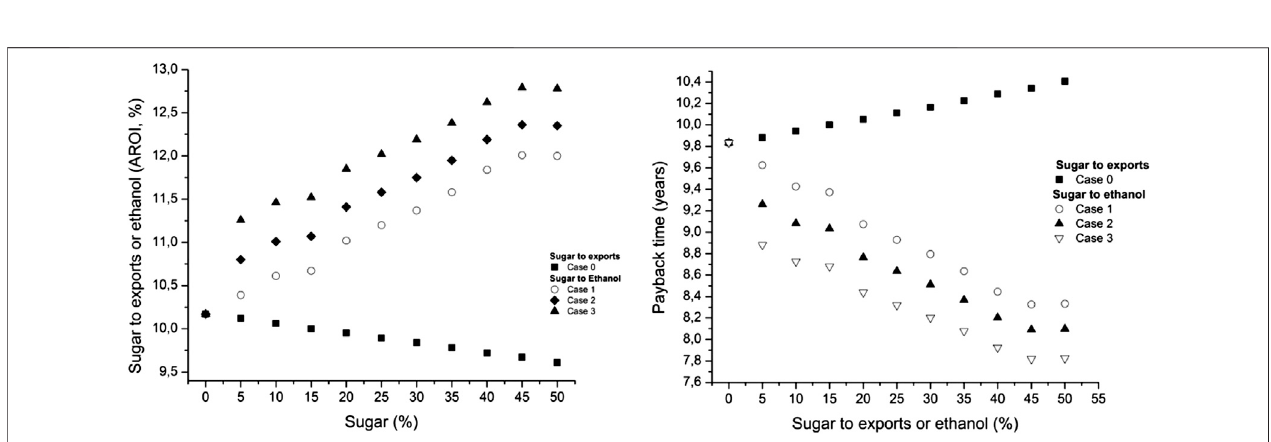
FIGURE 5 | Annual return on investment (AROI, left) and payback time ( P Bt, right) for scenario 1 for sugar to exports and scenario 2 for sugar to ethanol.